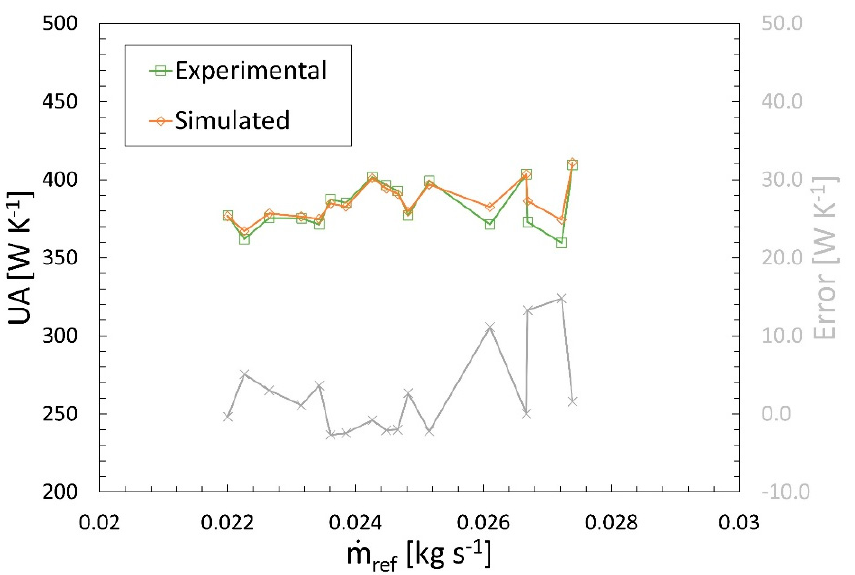
Figure 16. Comparison between the global conductance (UA) of the gas cooler calculated by the model and evaluated from the experimental data with different mass flow rate values under test conditions. The error of the model is shown on the secondary y -axis and represented by the gray line. Table 1. Effect of the mass flow rate variation due to the accuracy of the mass flowmeter on the predicted outlet temperature of the refrigerant. The actual measured value is considered for the other inputs. The simulated values within the range of error of the temperature sensor are highlighted with a green